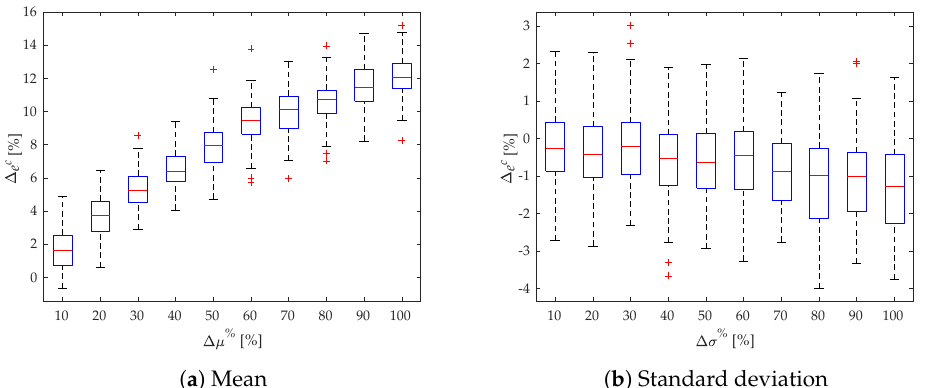
Figure 7. Variation of the parameters of the average charging duration.